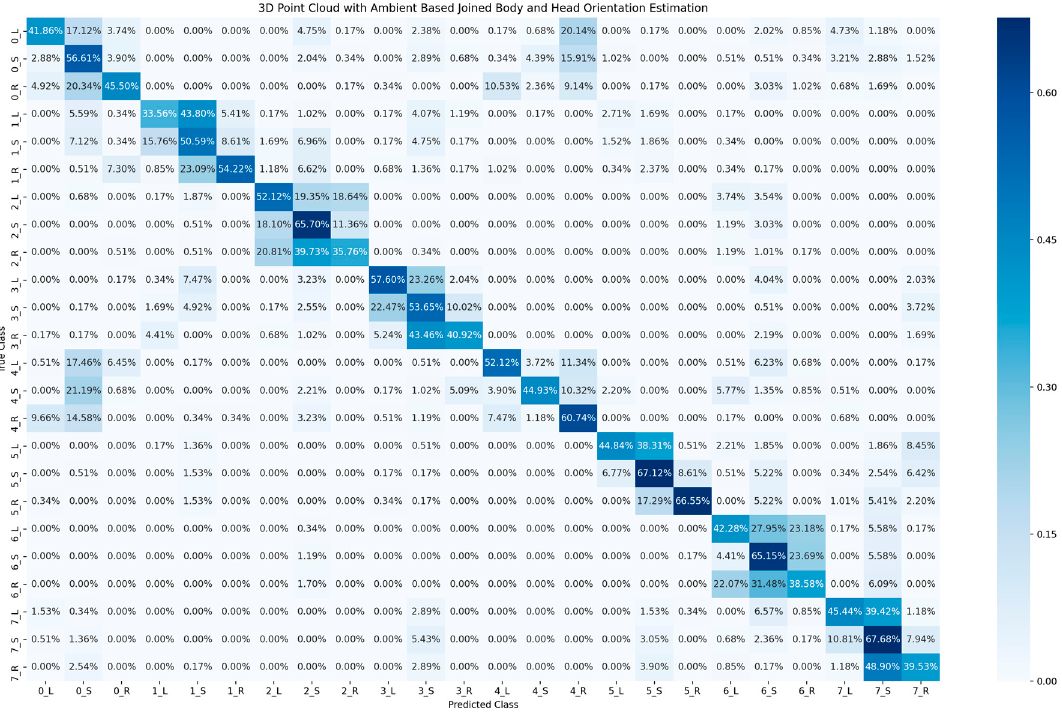
Figure 6. Confusion matrix of cyclist joined body and head orientation estimation using 3D point cloud data with ambient.